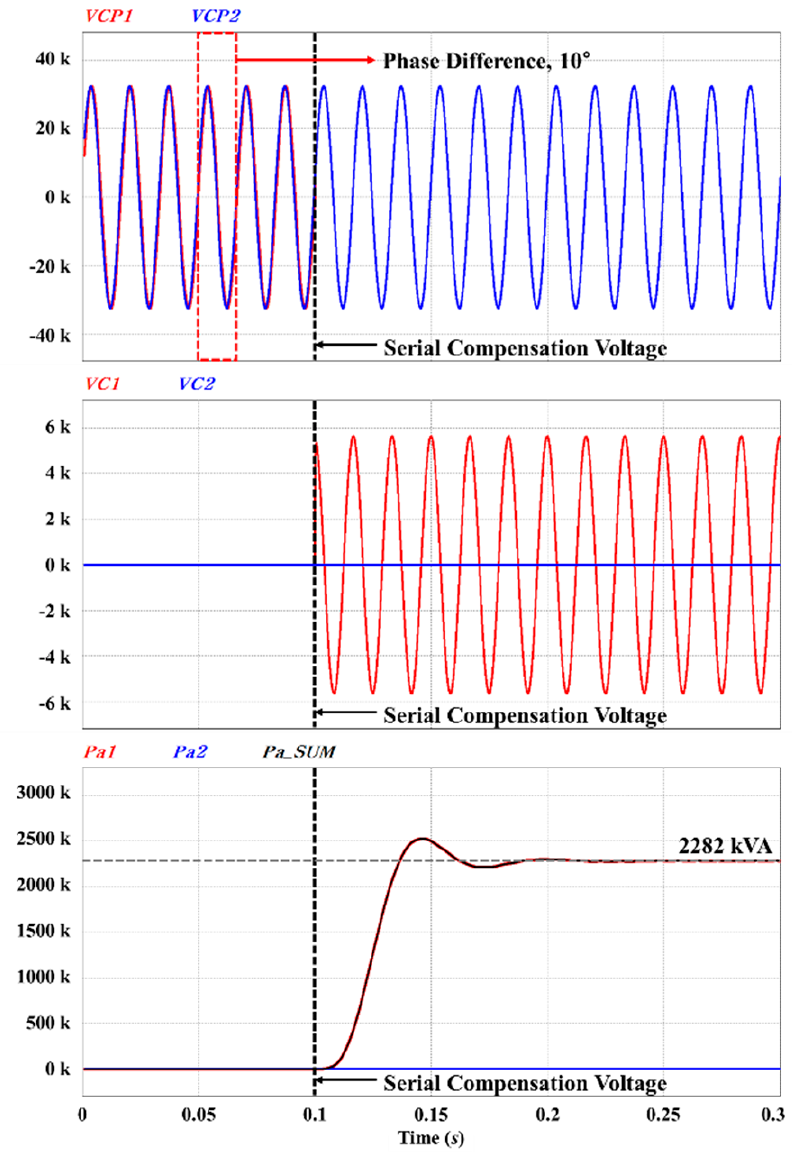
Figure 12. Connection point voltage and APC capacity at the controlled angle of 10°.